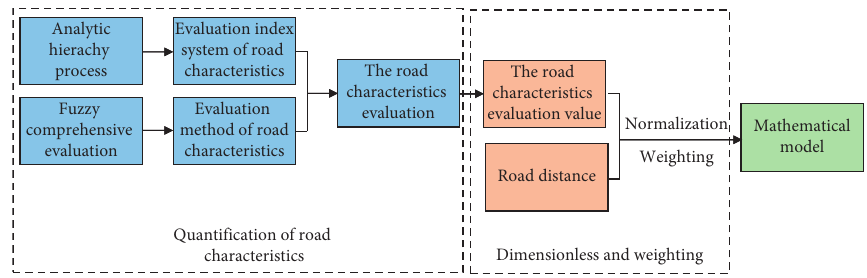
Figure 2: The block diagram for process of mathematical model